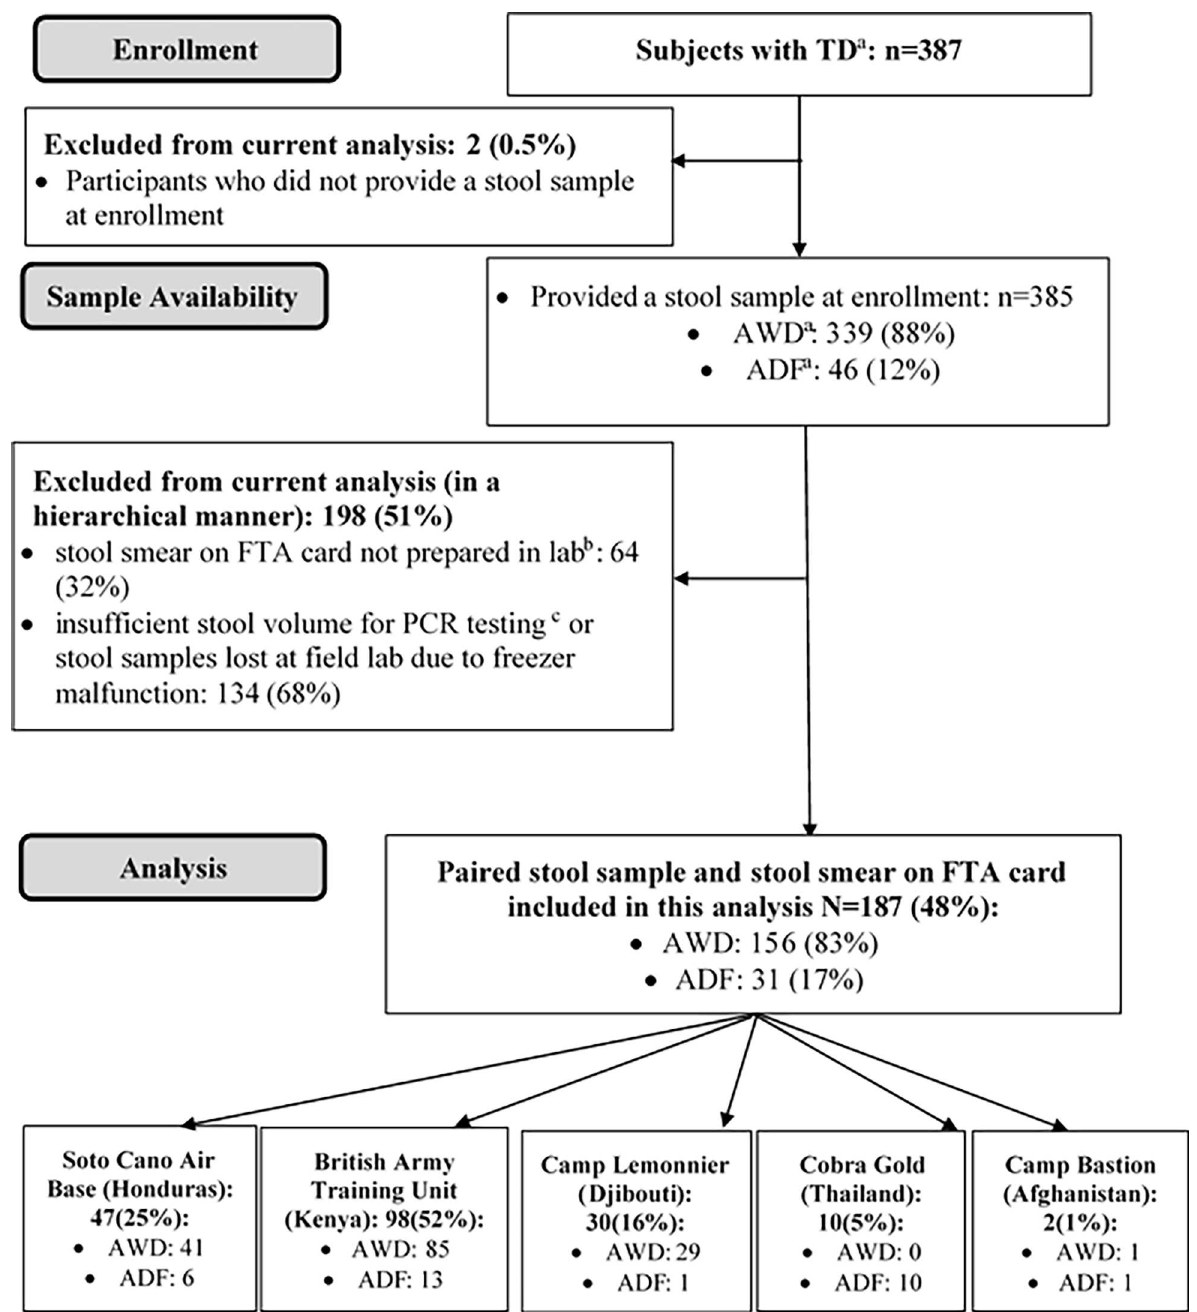
Fig 1. Flow diagram of patients enrolled in the TrEAT TD clinical trial and paired samples that were included in the present analysis. https://doi.org/10.1371/journal.pone.0202178.g001 was 0.80 (95% CI: 0.77–0.82). The agreement for bacterial targets ( κ = 0.82; 95% CI: 0.80–0.85) was higher than for viral targets ( κ = 0.48; 95% CI: 0.34–0.62). Using the TAC results on frozen stool as the reference, the overall pathogen detection sensitivity and specificity for TAC on FTA cards was 72.9% and 98.0% respectively. The sensitivity increased to 90.0% when restrict- ing to FTA cards with a corresponding frozen stool Cq < 30—Table 2. The sensitivity of TAC